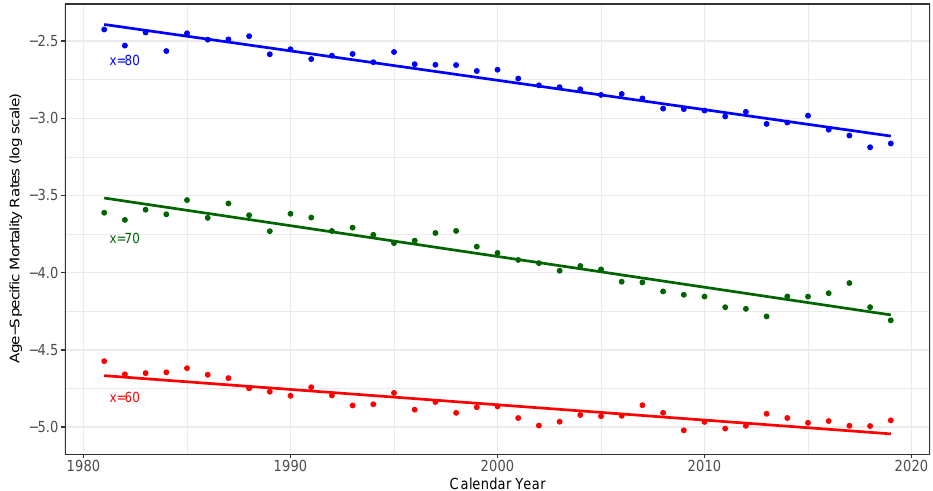
Figure 4. Observed log m ( t , x ) values of the total population in Greece, for ages 60, 70, 80, over the period 1981–2019. The straight lines denote the trend in mortality